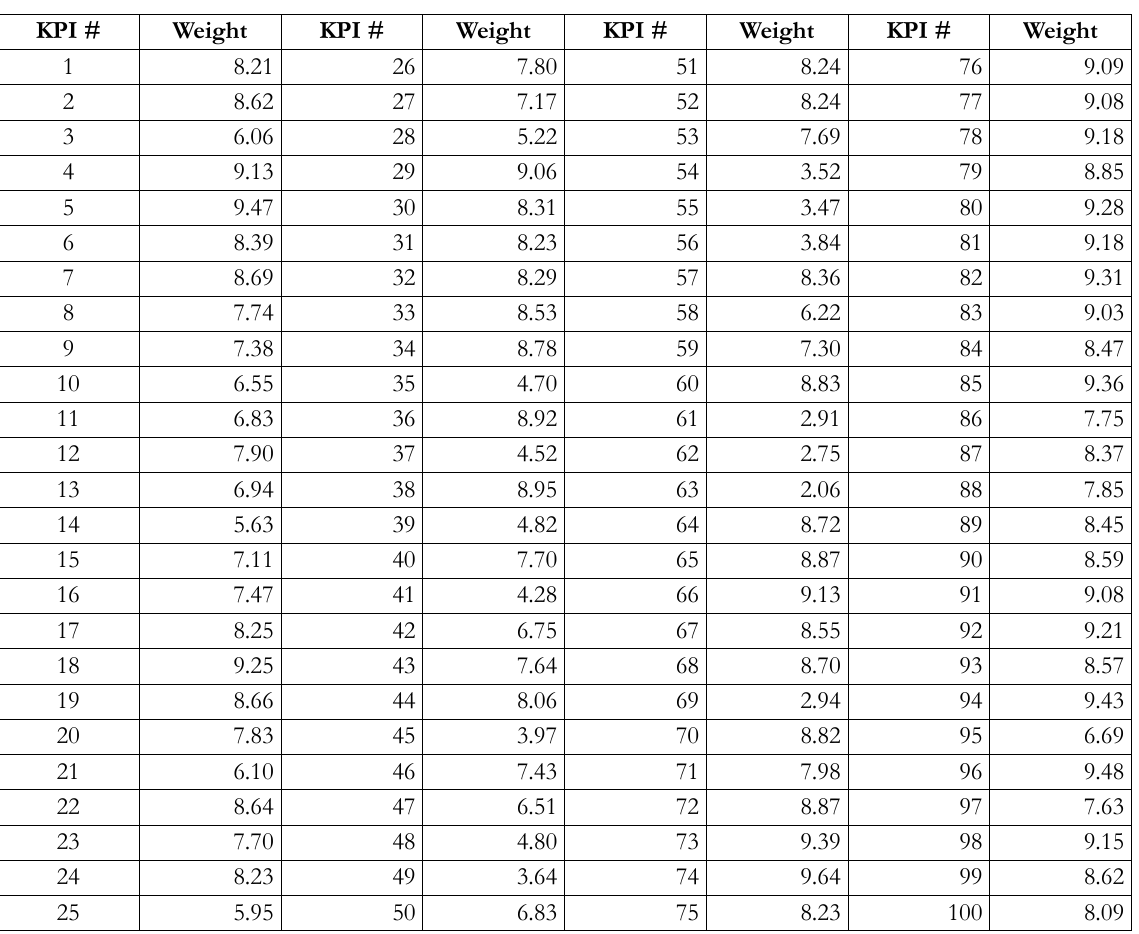
Table 1. Average weights for the 100 KPIs in the Technology Integration